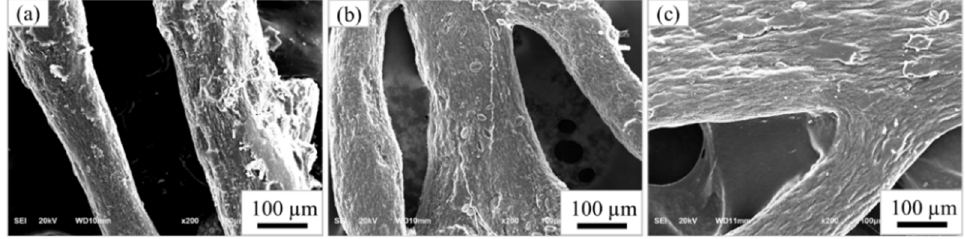
Figure 5. SEM micrographs (×200) of raw material ( a ) and pretreated sample, for the ( b ) first step and the ( c ) second step.